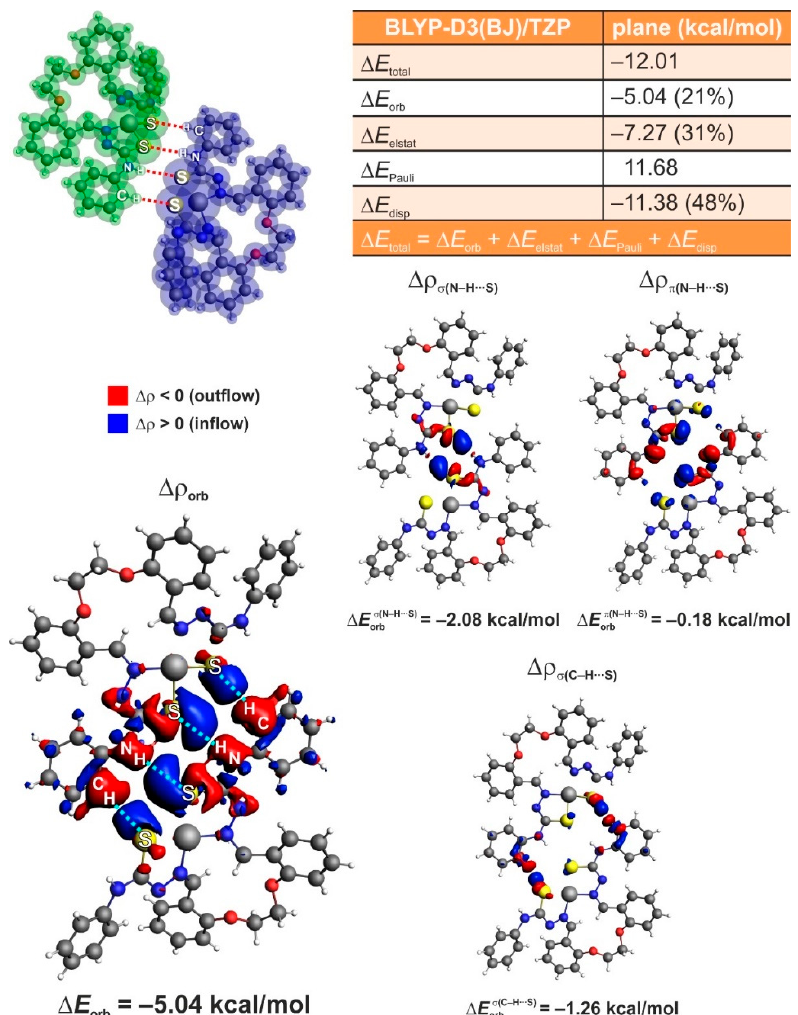
Figure 8. The results of ETS-NOCV energy decomposition describing N–H ··· S and C–H ··· S interac- tions between in-plane monomers in 1 . Additionally, the overall deformation density ∆ ρ orb with the corresponding Δ E orb are presented together with σ - and π -NOCV based contributions.